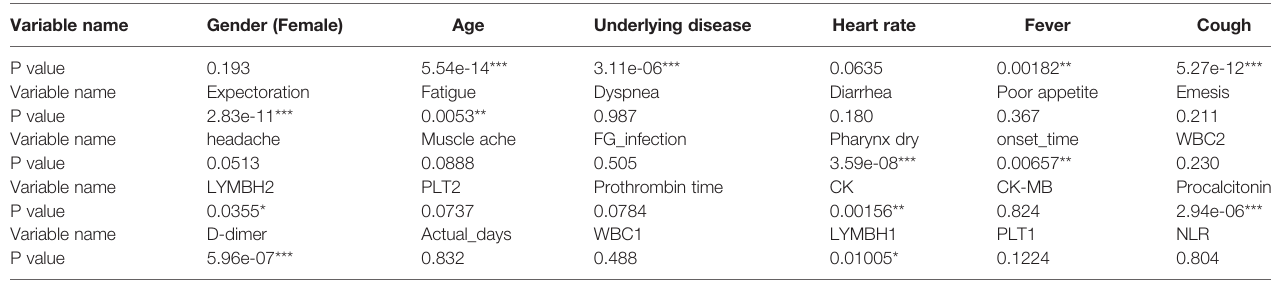
TABLE 3 | Signi fi cance of single-factor logistic regression variables.